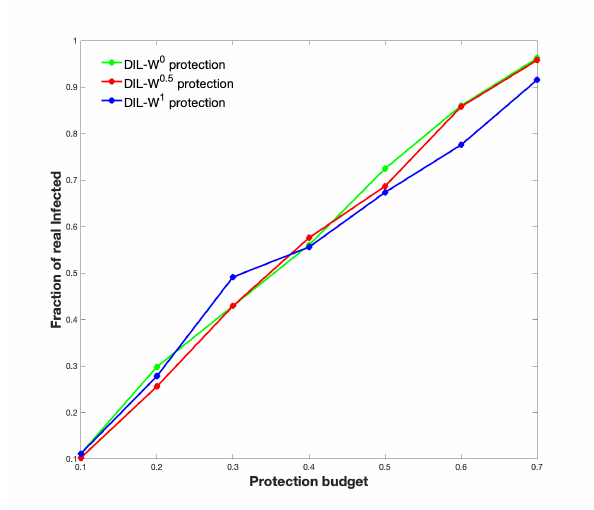
Figure 9. Survival rate of each ranking.